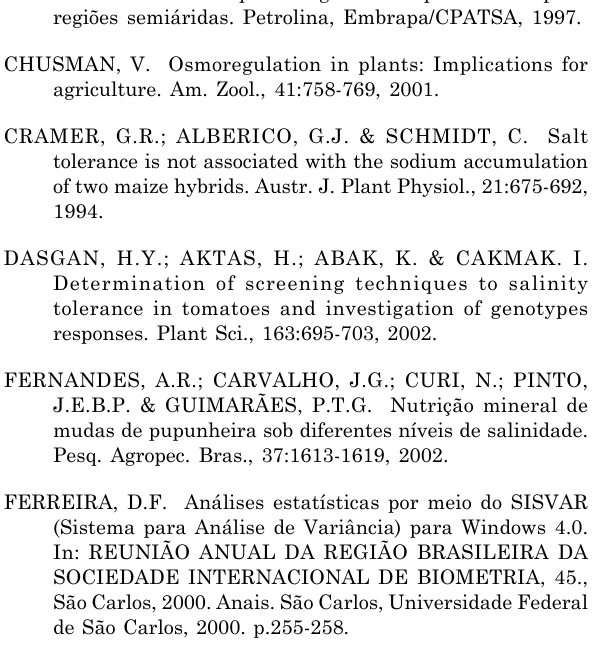
(Figura 2d). Esses resultados corroboram os observados por Miranda et al. (2002) em trabalhos com moringa nas concentrações de 0, 30, 60, 90 e 120 mol m -3 de NaCl, nos quais se verificaram reduções no acúmulo desses nutrientes com o aumento do